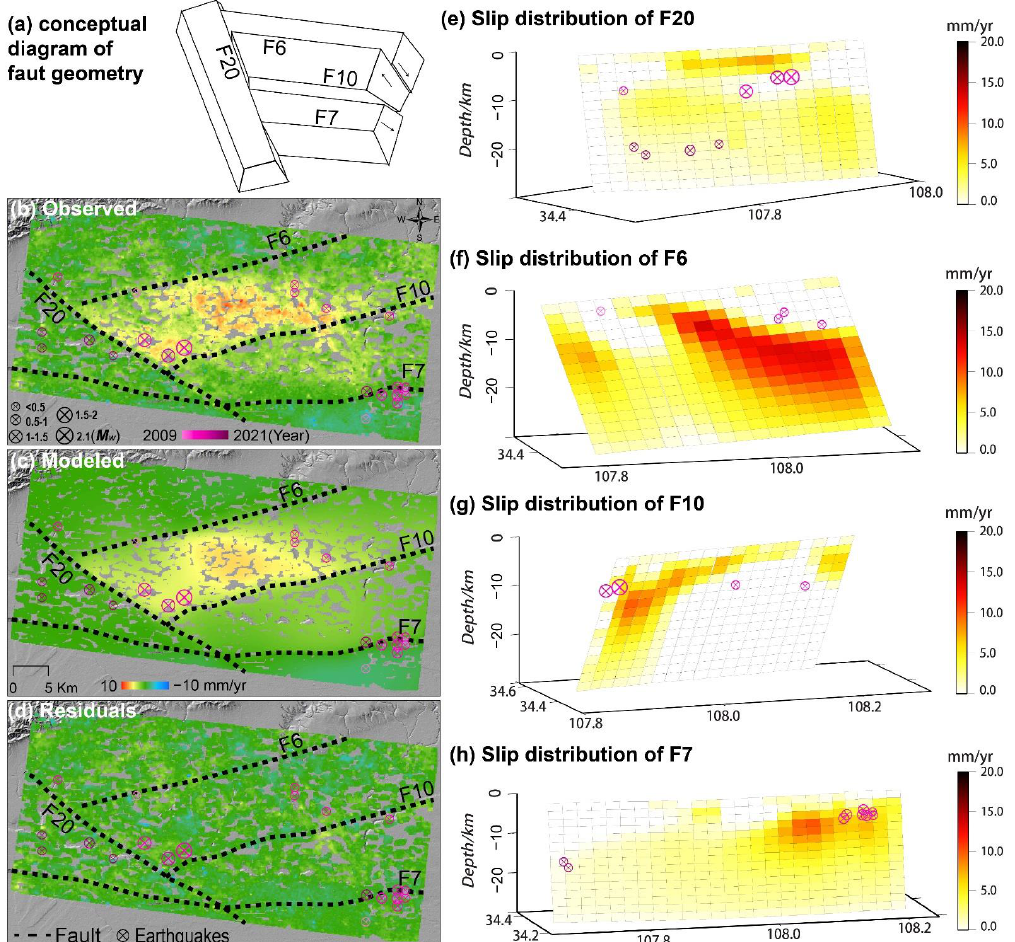
Figure 7. ( a ) Conceptual diagram of fault geometry; ( b ) decomposed average vertical deformation from InSAR maps; and ( c ) modeled deformation for ( b ) from slip models shown in panels ( e – h ). ( d ) Residual between ( b , c ). The black dashed lines show the fault traces. The pink circles are the locations of earthquakes that occurred during 2009 – 2021, and the graduated pink color displays the occurrence time of seismicity events.